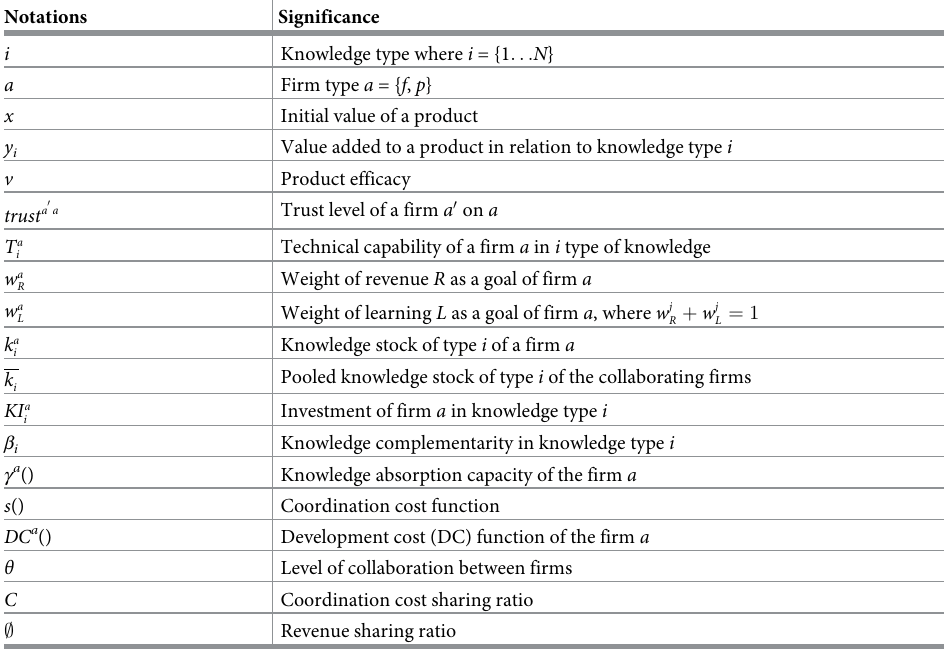
Table 1. List of